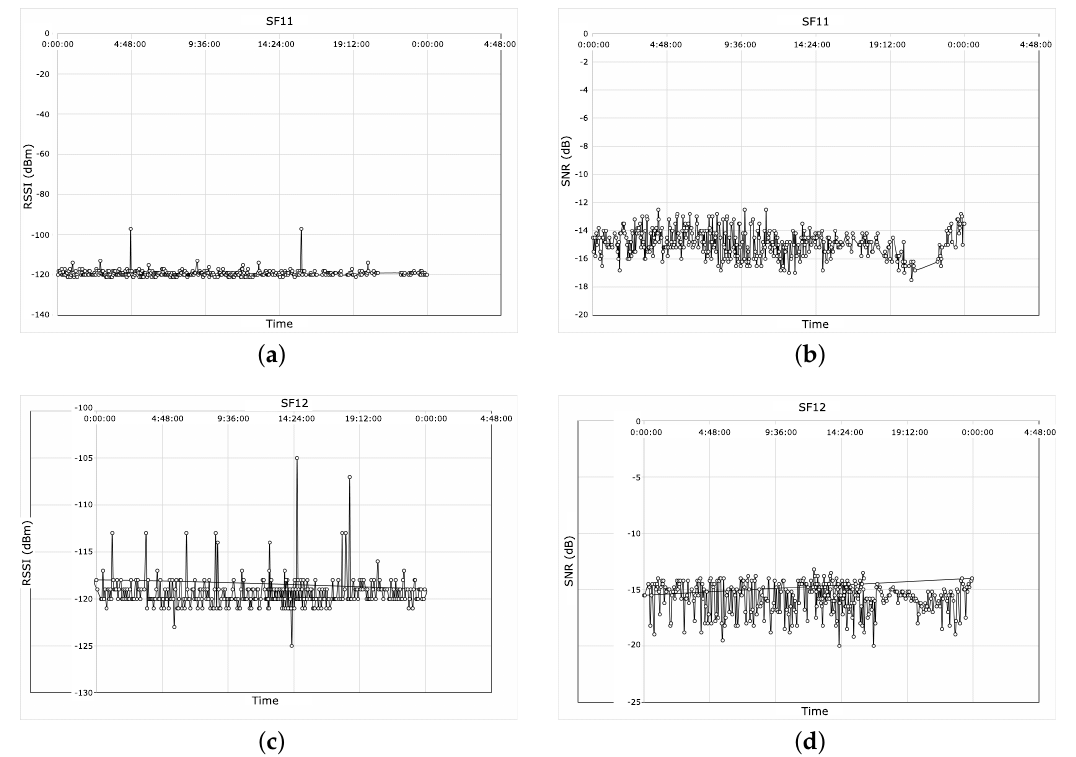
Figure 11. Coverage range tests. ( a ) Received signal strength indicator (RSSI) data (SF11). ( b )